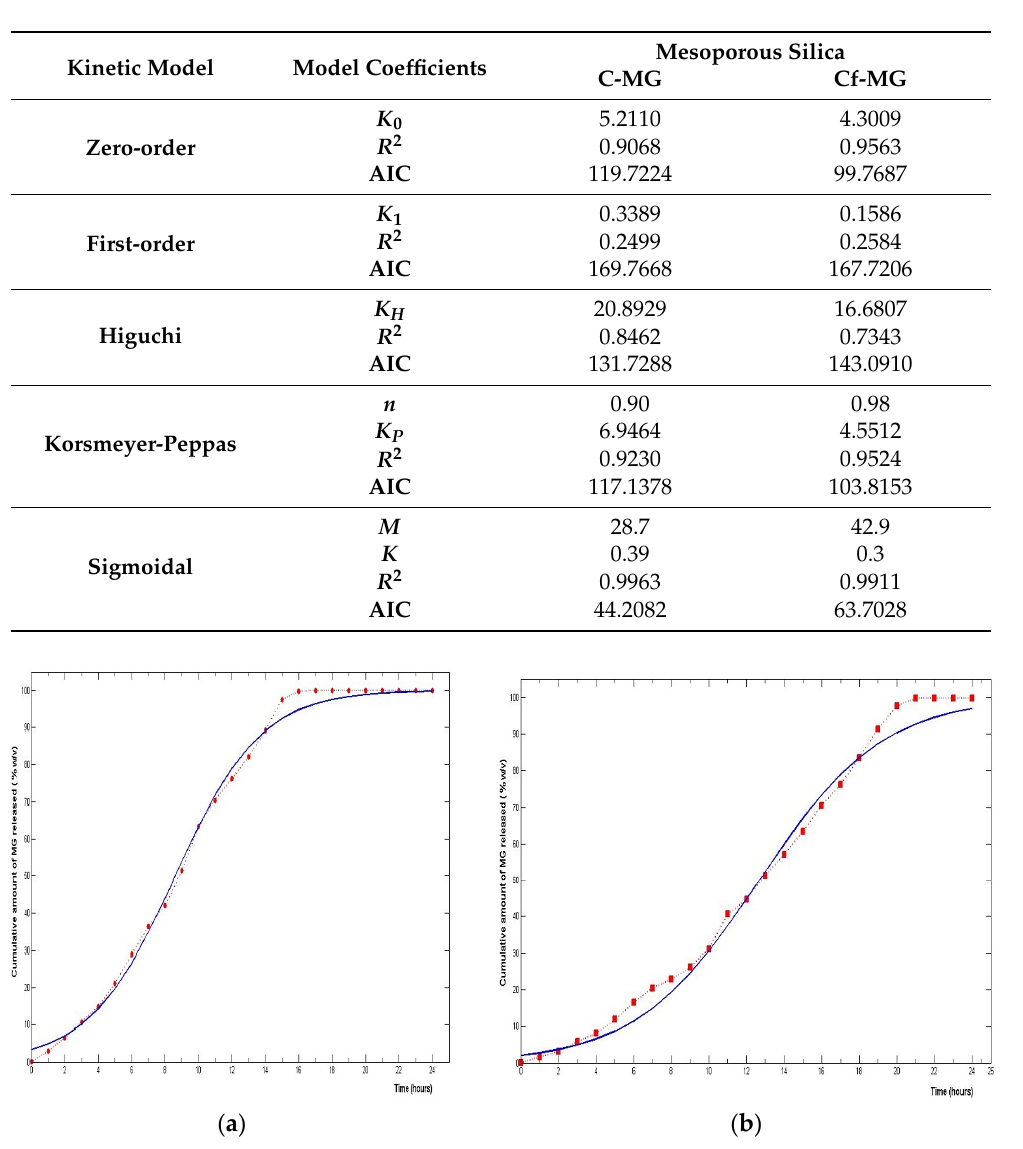
Figure 5. Sigmoidal plot of MG release from C ‐ MG ( a ) and Cf ‐ MG ( b ). Table 2. Results of curve fitting of the in vitro release profile of magnolol (MG) from mesoporous silica SBA ‐ 15.